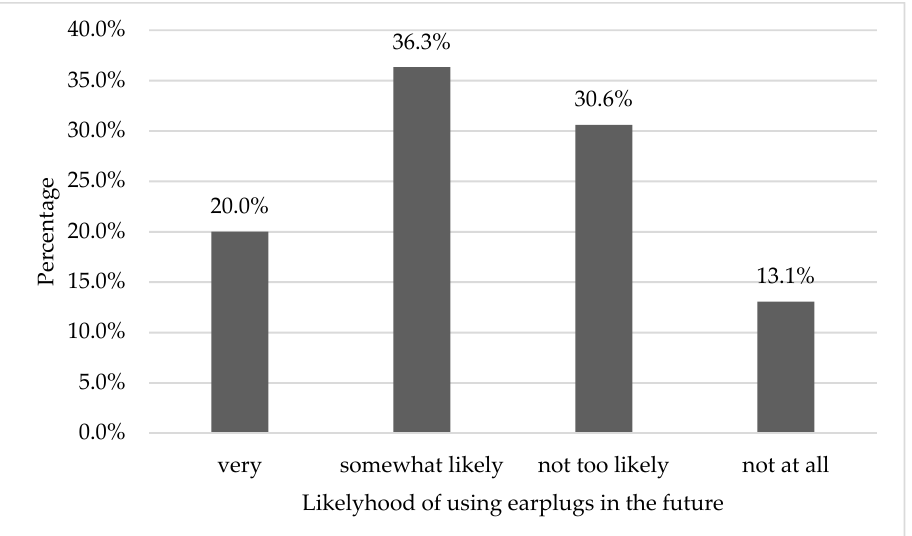
Figure 3. Likelihood of using earplugs and ear protection in the future.